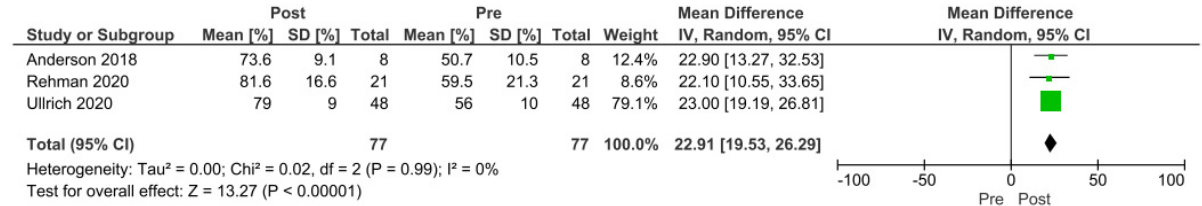
Figure 2. Forest plot of knowledge improvement after (Post) participation in a relevant trauma surgery simulation course. Green squares = weighted mean difference. Black diamond = overall weighted mean difference.